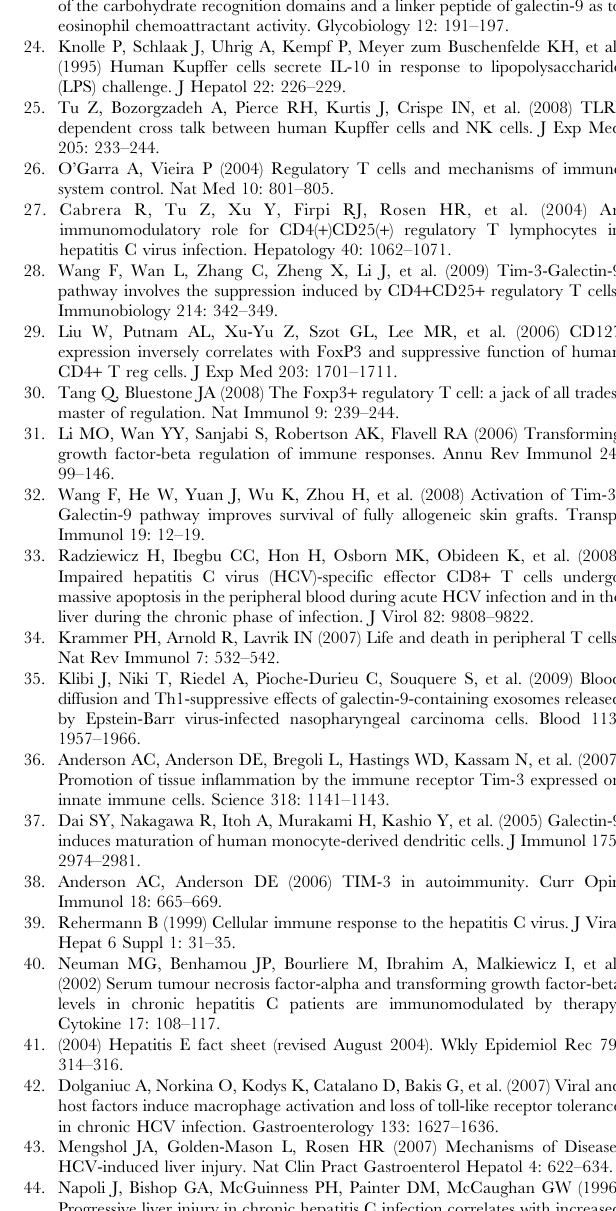
Figure S2 Interferon- c induces Galectin-9 mRNA in THP-1 cells. 10 6 THP-1 cells/ml were cultured in 20 ng/ml IFN- c for the times indicated in triplicate. RNA was isolated, reverse transcribed and analyzed by TaqMan real time PCR using GAPDH as a control. P-values were calculated using a